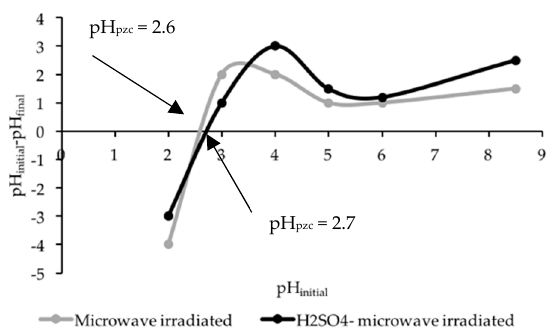
Figure 4. Point of zero charge analysis for microwave-irradiated and H 2 SO 4 –microwave-irradiated POMB-retained ash.